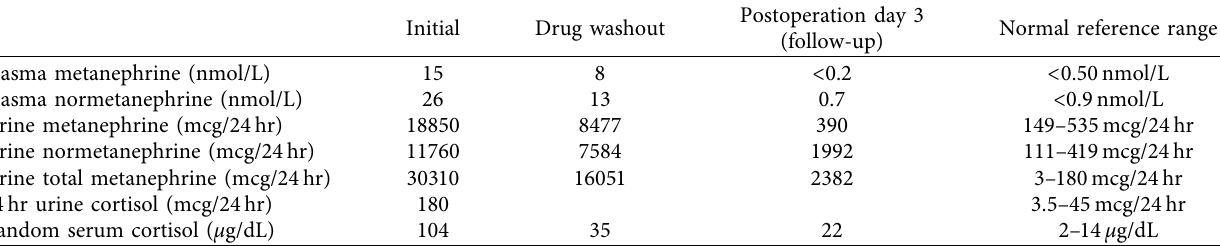
Figure 1: CTabdomen/pelvis with contrast showing a heterogenous 12.5cm × 10.7 × 9.4cm left adrenal mass coronal view (a) and axial view Table 1: Summary of patients’ laboratory evaluation data during initial workup, after 1 week of drug washout period, and following surgical removal of her tumor.